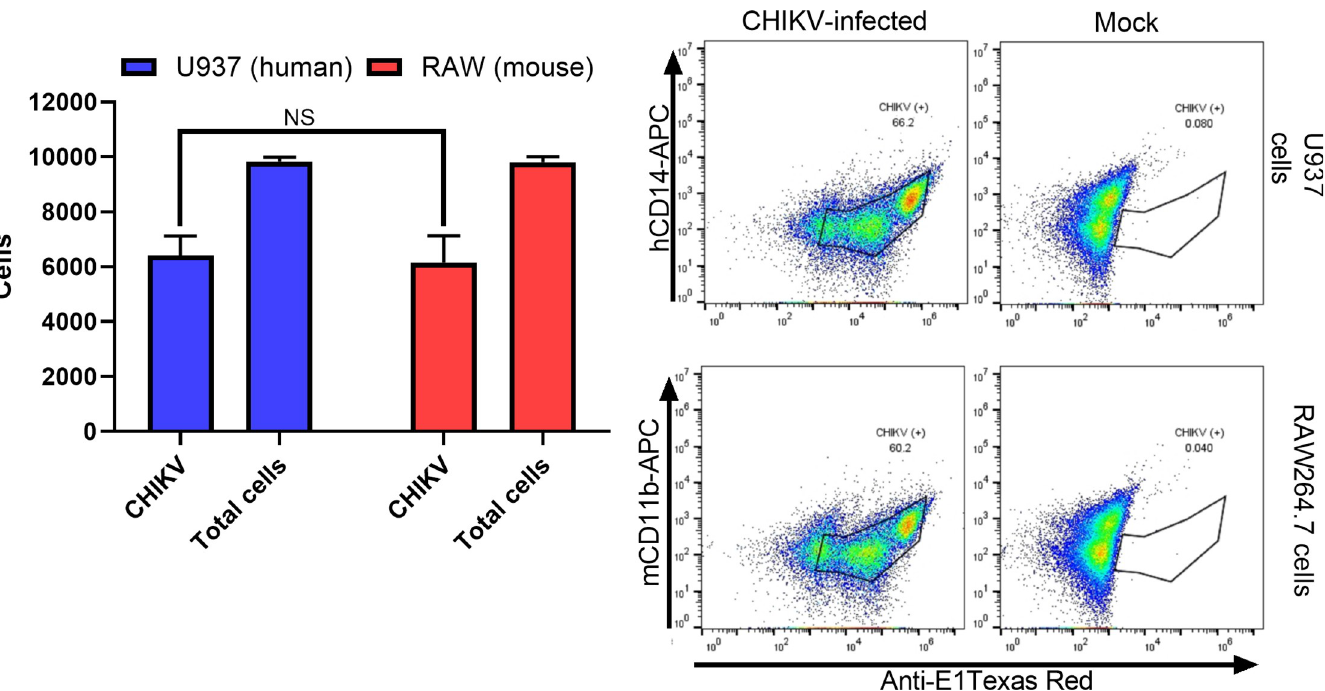
Fig 4. PMA-differentiated U937 and RAW264.7 cells display CHIKV envelope proteins at 6 hpi. PMA-differentiated U937 and RAW264.7 macrophages were exposed for 2 hours to CHIKV and then fixed and assayed at 8 hpi using flow cytometry and an anti-E1 protein fluorophore-conjugated monoclonal antibody. Data show mean values of three independent experiments with a total of n = 9, MOI = 1. Statistical significance was determined using multiple t-test corrected using Holm- Sidak method. � P < 0.05; NS, not significant.